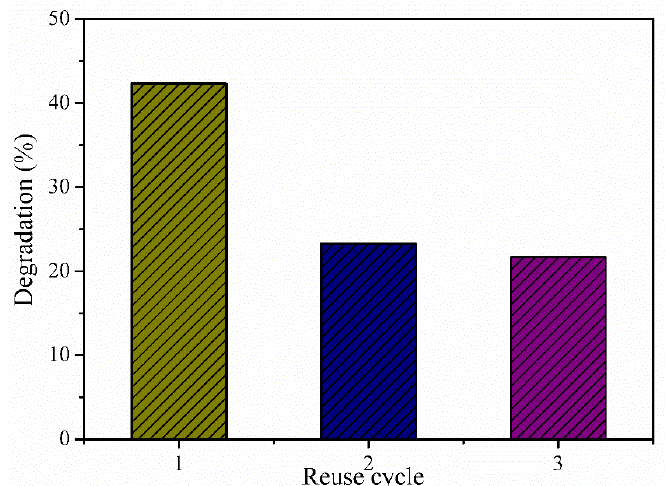
Figure 8. Reuse of Zn 0.94 Er 0.02 Cr 0.04 O for photocatalysis in three consecutive